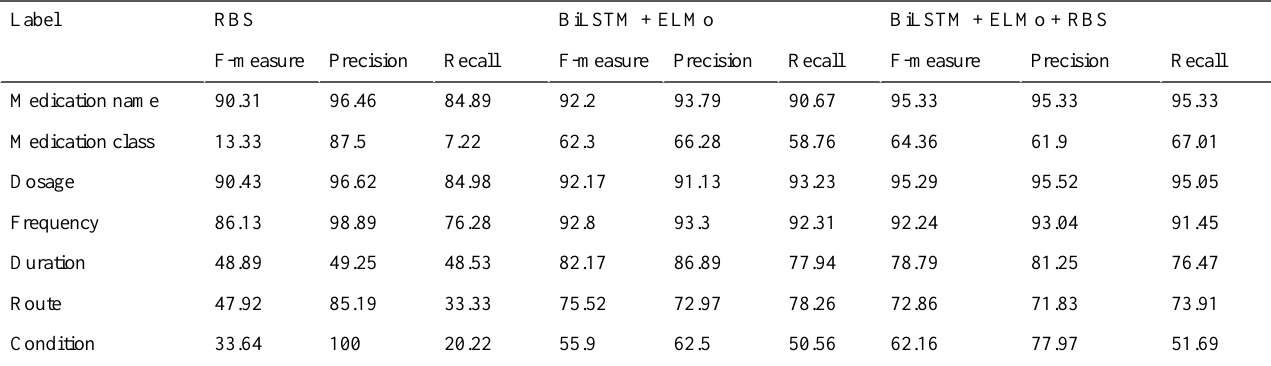
Table 4. Medication information predictions metrics results by